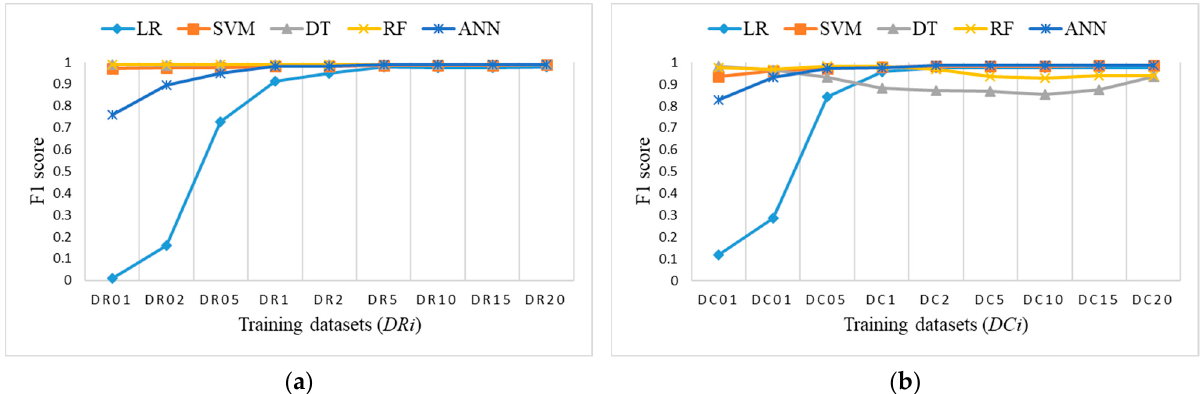
Figure 16. F1 score on test dataset for: ( a ) Balanced datasets DRi with reduced class ‘NL’ (coincidence of RF and DT); ( b ) balanced sets DCi with clustering.